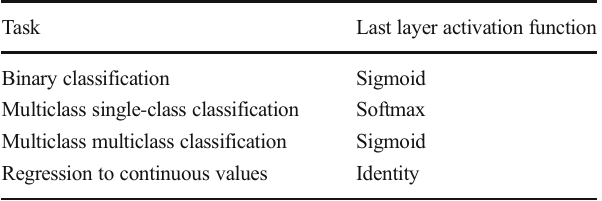
A list of commonly applied last layer activation functions for various tasks Task